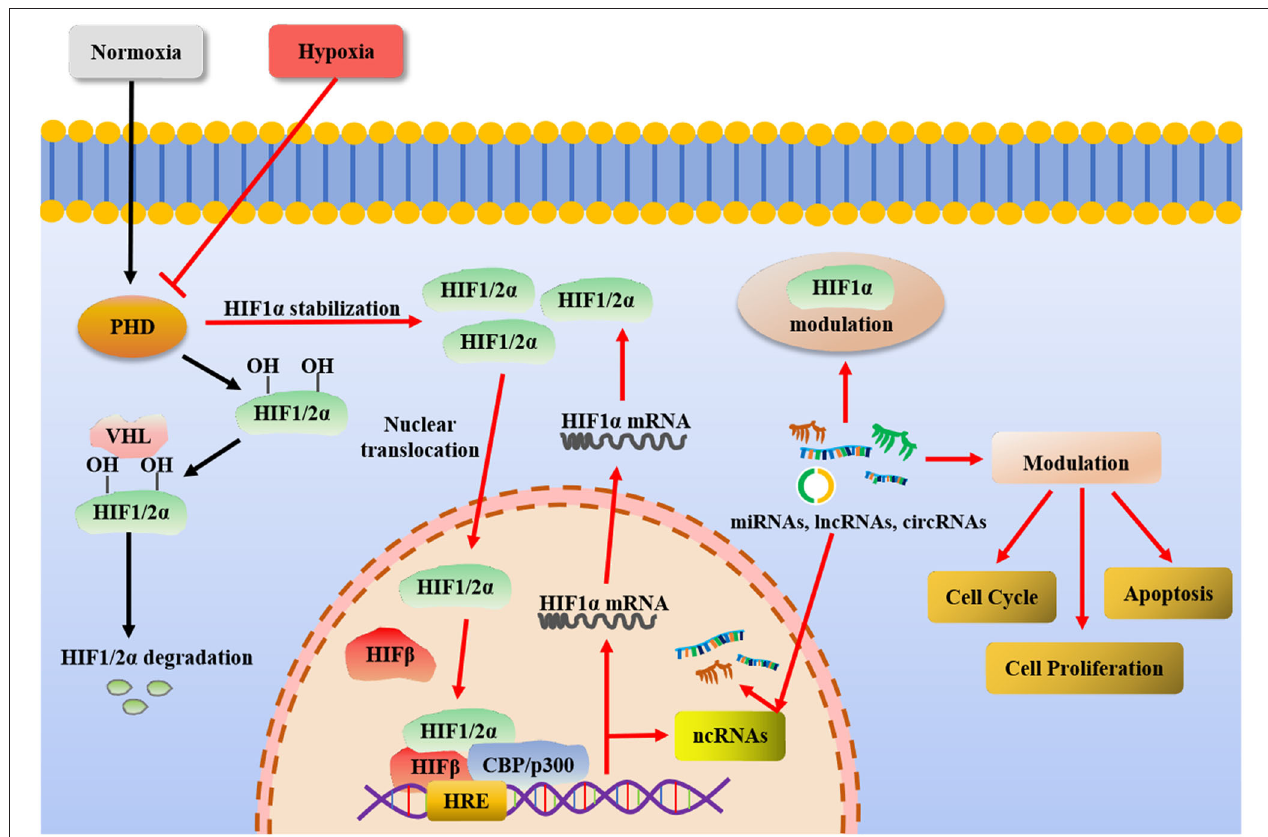
FIGURE 1 | Under normoxia, PHDs and other proline hydroxylases hydroxylate the subunits of HIF-1/2 α . The VHL protein further recognizes the hydroxylated HIF-1/2 α as a target for subsequent ubiquitination and proteasome degradation. Under hypoxia, HIF-1/2 α cannot be hydroxylated and gradually accumulates, nuclear translocation, and forms dimers with HIF- β . It forms a transcription initiation complex with the recruited CBP/p300 and binds to the promoter of the target gene to induce target gene expression. Hypoxia can induce the expression of ncRNAs. ncRNAs including miRNAs, lncRNAs, or circRNAs are involved in regulating cell proliferation, cell cycle and cell death and other cell